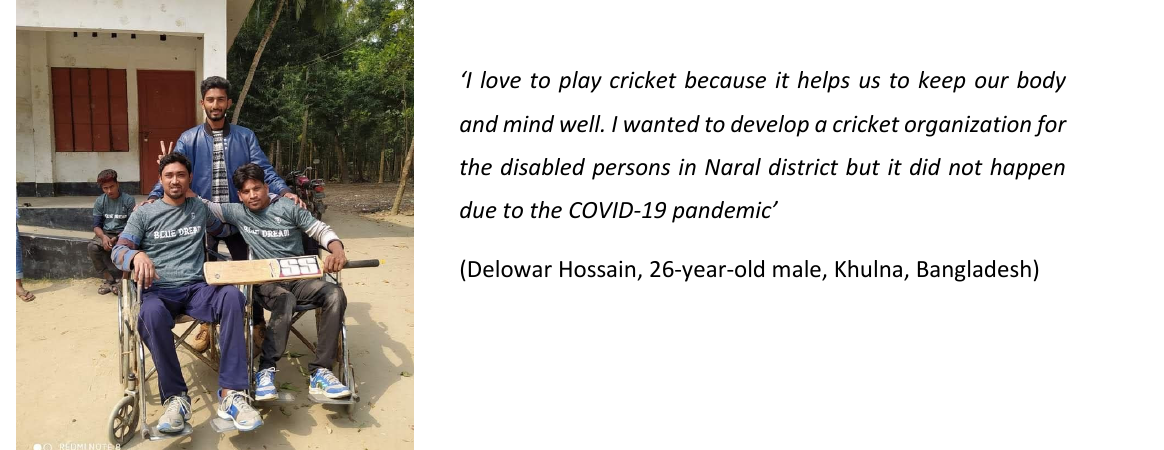
Figure 8. Alt-text: Three young men posing outdoors—two young men in wheelchairs smiling and posing with a cricket bat, and another standing behind them.